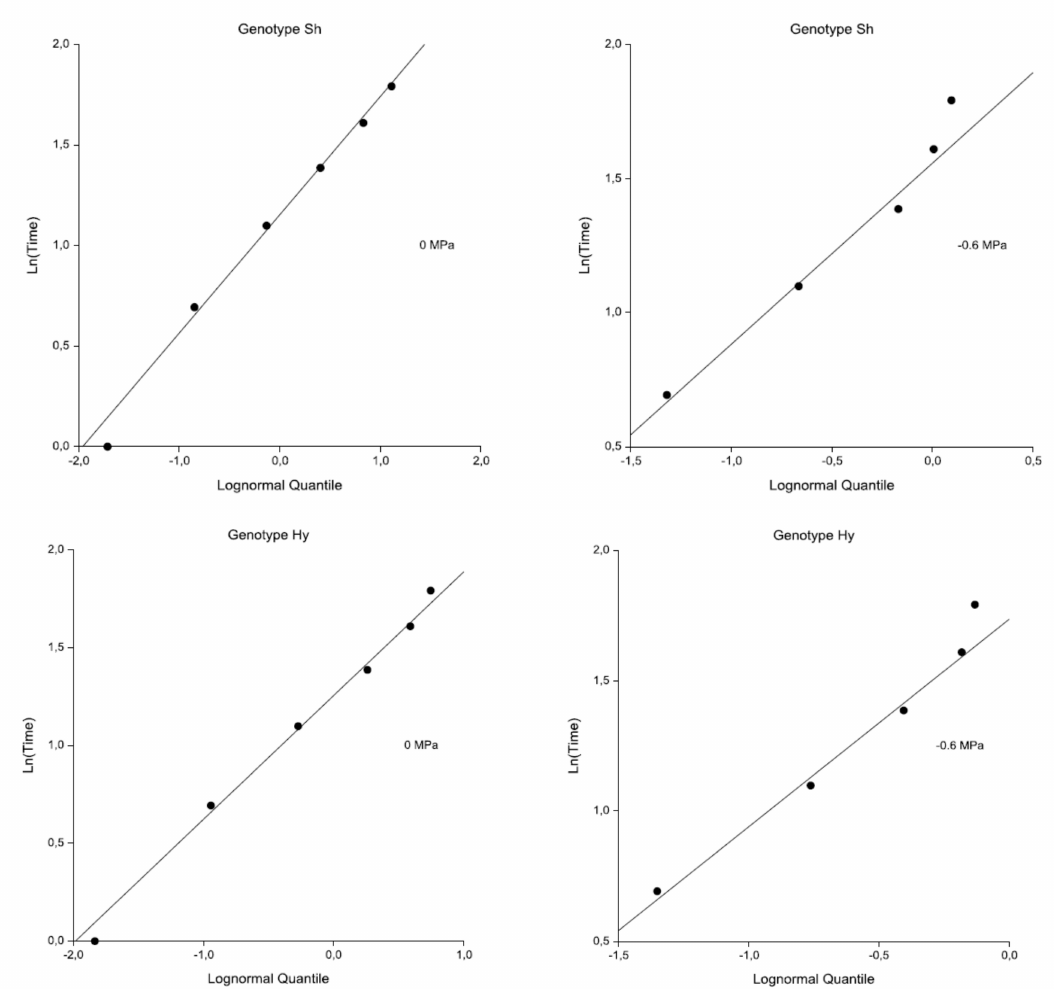
Figure 3. Log-normal distribution probability plots for Sh and Hy genotypes. On the horizontal axis, the expected quantile of the theoretical distribution, Φ − 1 (1 − e − H(t) ), where H (t) is the cumulative hazard rate and Φ is the standard normal distribution function; on the vertical axis, the natural logarithm of the time value. For tied data, only one point is shown for each set of